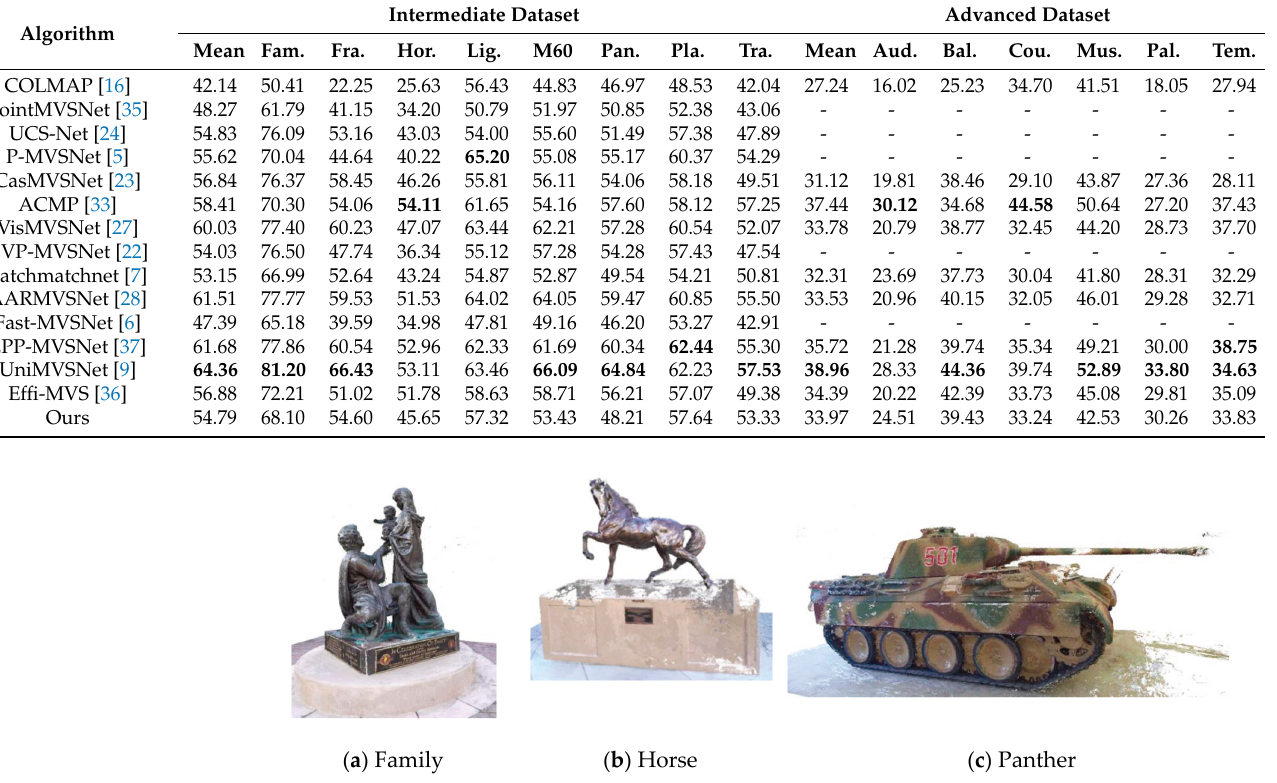
Figure 6. Demonstration of the point cloud reconstruction effect of the Tanks and Temples dataset. ( a ) Family point cloud reconstruction. ( b ) Horse point cloud reconstruction. ( c ) Panther point cloud reconstruction.